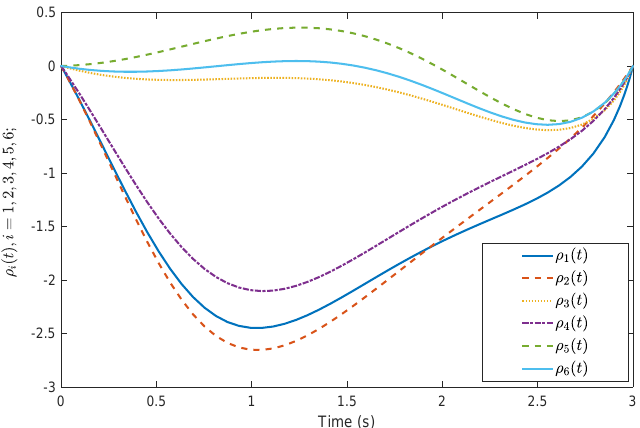
Figure 8. Velocity states ρ (t) by the prescribed-time Controller (62).